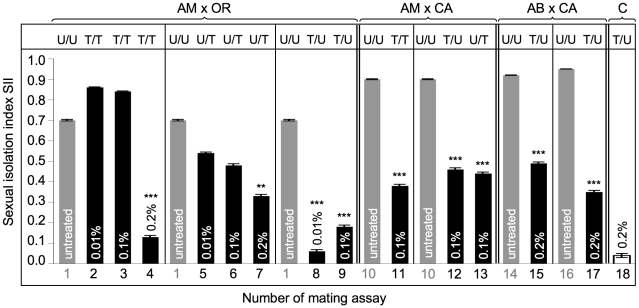
Mating preferences in combinations between untreated and treated heterogamic pairs of D. paulistorum semispecies.y-axis represents sexual isolation index (SII); number of mating assay (1–18) is shown on x-axis (corresponding to assay numbers in Table S2). Grey bars indicate untreated controls; black bars indicate assays with Rifampicin treated flies: Tested lines were kept on 0.01% Rifampicin for ten generations; or on 0.1% and 0.2% Rifampicin for five generations. SII and standard error (SE) were determined following [75]. For each array five replicates and 120 matings were scored (12A ♀♀ +12B ♀♀ +12A ♂♂ +12B ♂♂ differentiated by rotated wing clips) for each row, totaling 2,160 matings. Two-tailed P values were calculated by comparing SIIs of untreated and treated pairs of mating choice assays by Fisher's exact test. Statistically significant results are indicated by one, two or three asterisks, i.e., P<0.05; P<0.01 and P<0.001, respectively. Abbreviations: Amazonian (AM); Centroamerican (CA); Orinocan (OR) and Andean-Brazilian (AB) semispecies (lines POA1 and POA10). U =  untreated; T =  treated with antibiotics.